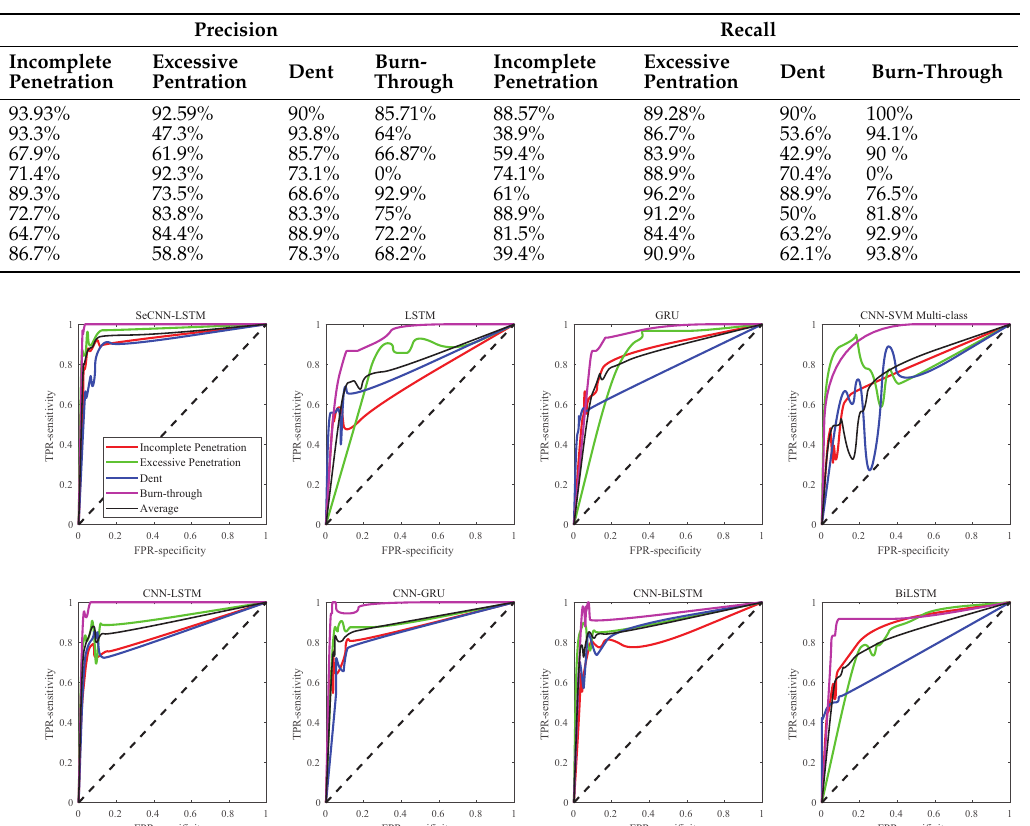
Table 3. Accuracy, precision and recall comparison.